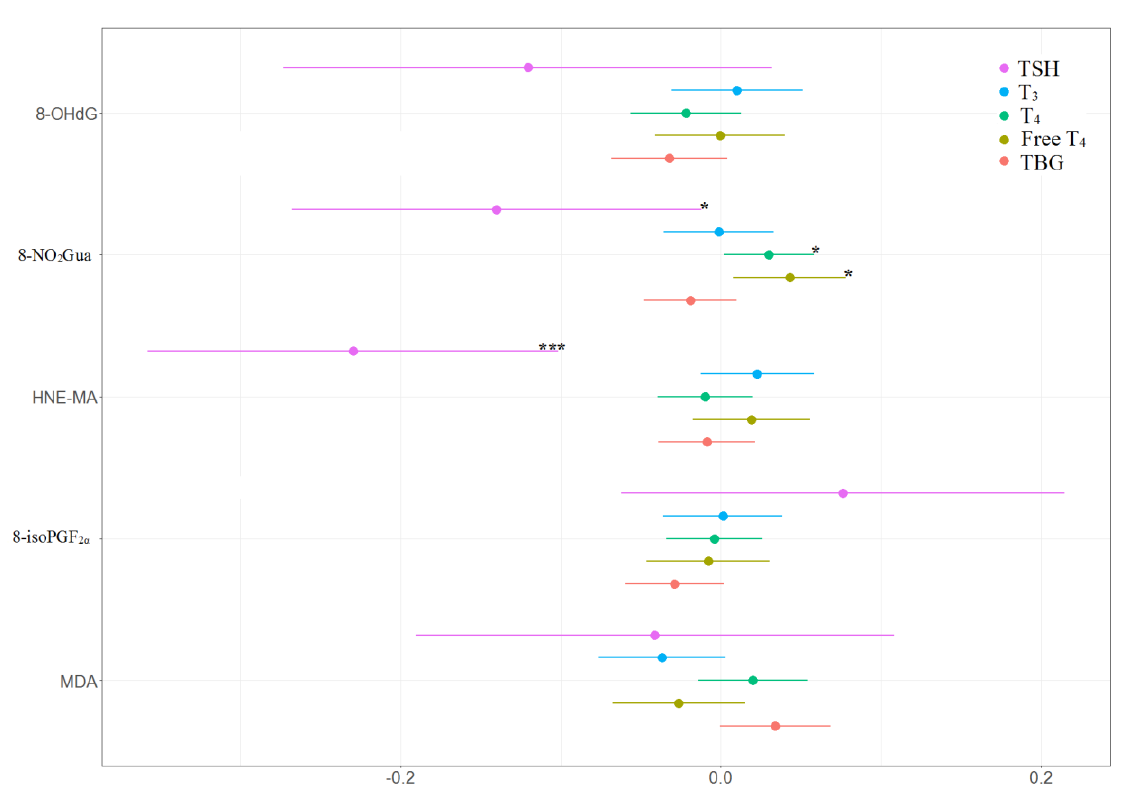
Figure 4. Percent changes in concentrations of thyroid hormones in association with tertile increase in oxidative/nitrosative stress biomarkers concentrations across three visits. Linear mixed models with random intercept were adjusted for age and creatinine; * p < 0.05, ** p < 0.01, *** p < 0.001.